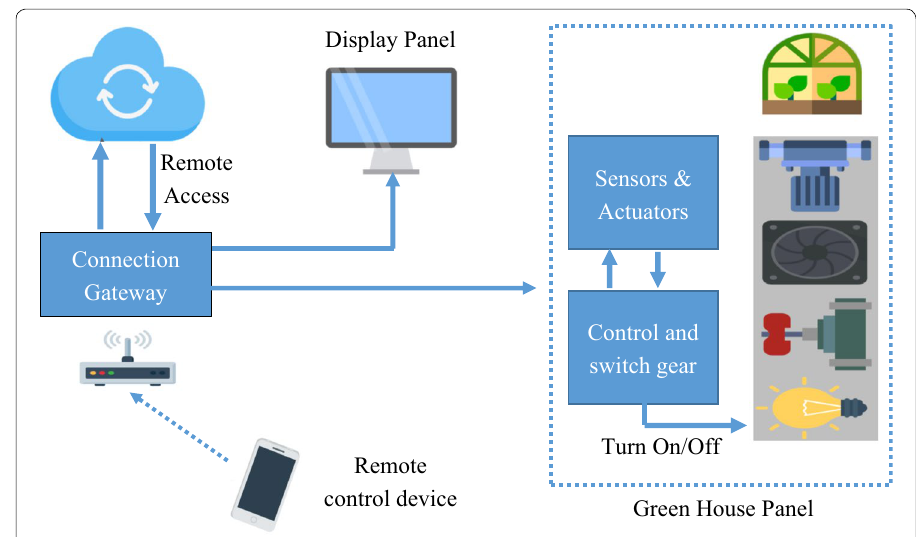
Fig. 9 A working structure of IoT system in agriculture